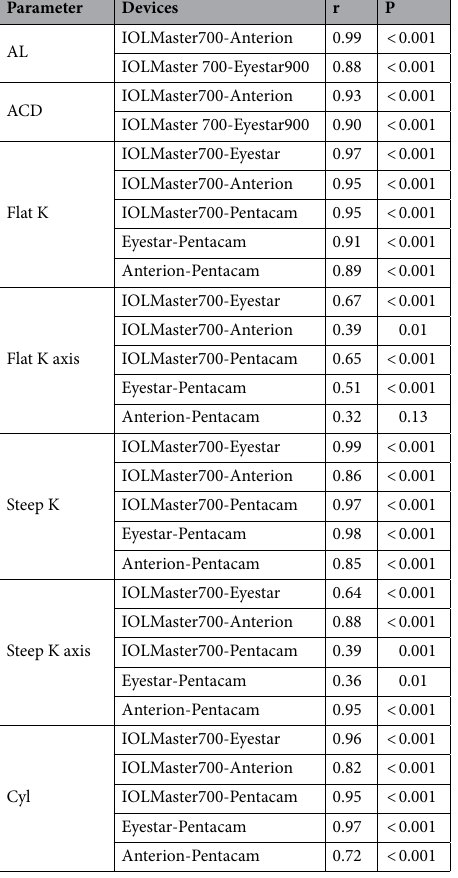
Table 4. Matrix of correlations. ACD anterior chamber depth, AL Axial length, Cyl cylinder.